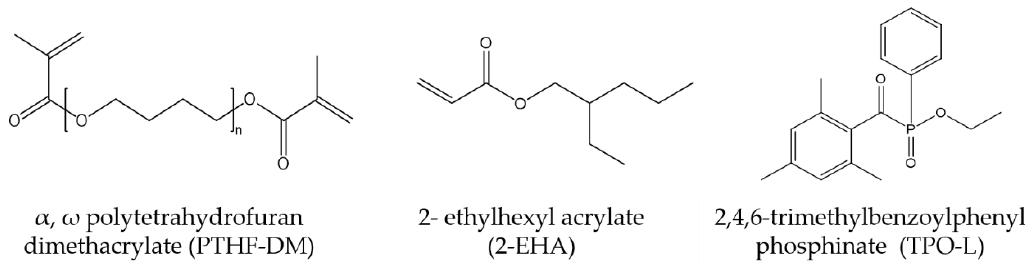
Figure 4. Components of photobleaching systems: difunctional PTHF 2900 -DM and 2-ethylhexyl acrylate in combination with TPO-L.